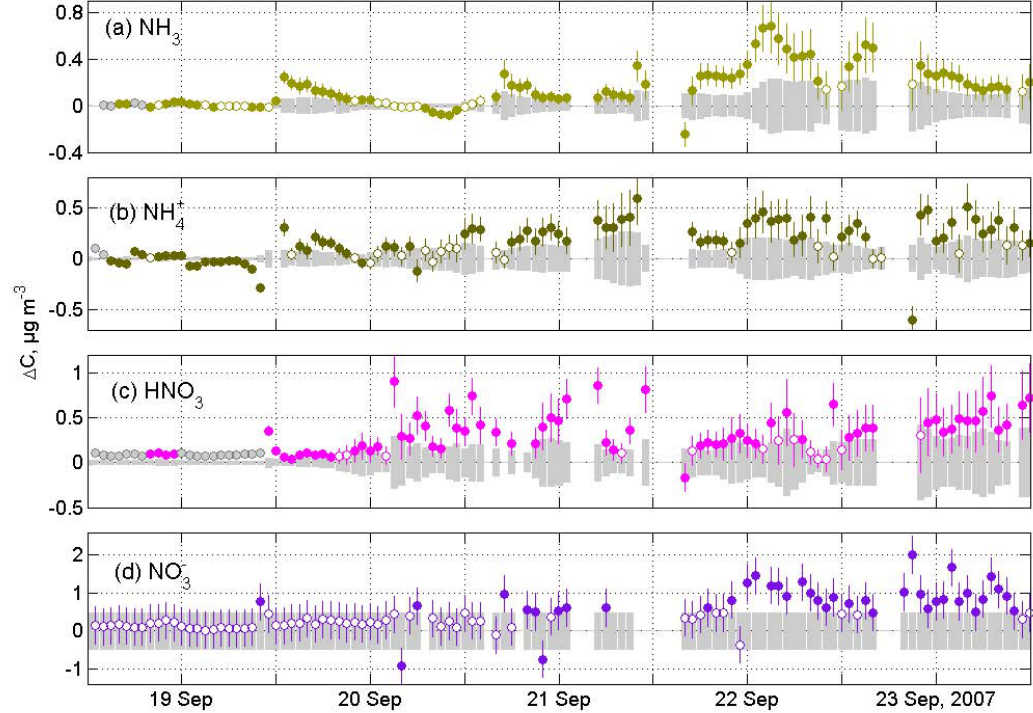
Fig. 12. Measured 1C values above the spruce forest canopy for some days during EGER. Error bars and uncertainty ranges (grey bars) for (a) NH 3 , (b) particulate NH + , (c) HNO 3 and (d) particulate NO − were determined from the residual analysis described in the text. The 4 3 hollow circles are values of 1C that are statistically not significant different from zero, the filled circles are significant 1C values. Grey circles are values of 1C where one or both concentrations were below the